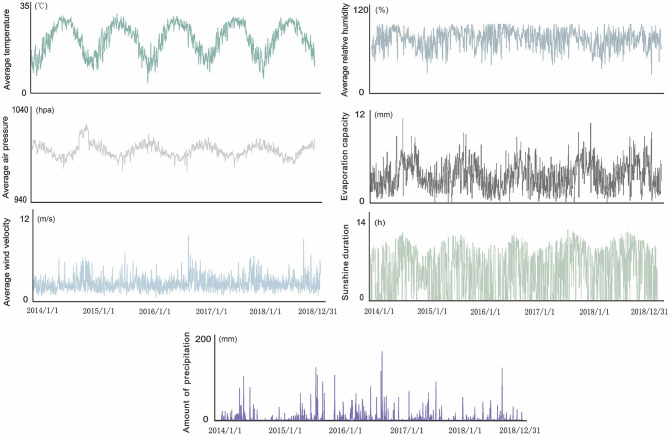
Daily variation in meteorological factors from 2014 to 2018.